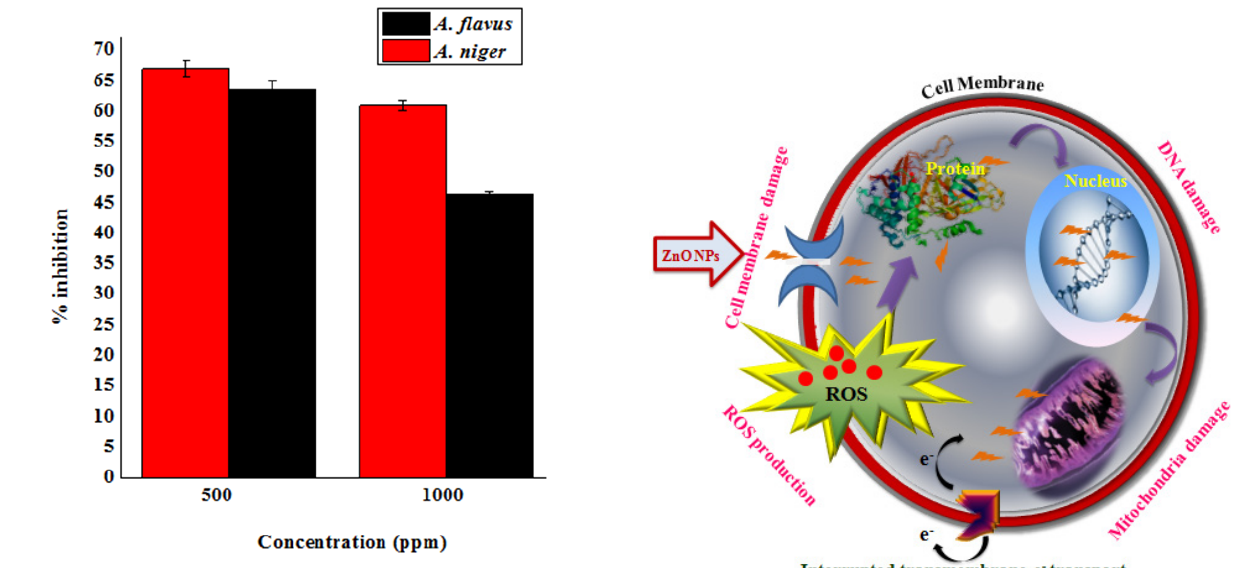
Figure 8: Antifungal potential of ZnO NPs against A. flavus and A. niger .